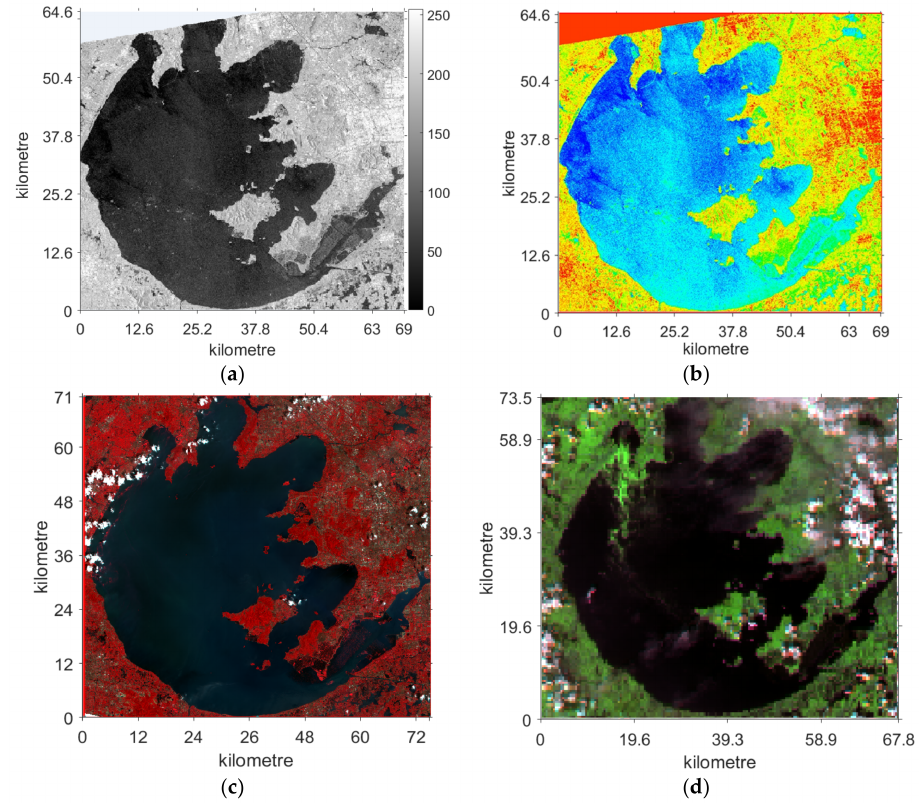
Figure 4. Preprocessed images of Taihu Lake: ( a ) acquired SAR image from Sentinel-1A on 25 July 2015; ( b ) false color image of Figure 4a; ( c ) acquired optical image from Landsat-8 on 27 July 2015; and ( d ) acquired optical image from MODIS on 11 September 2015.